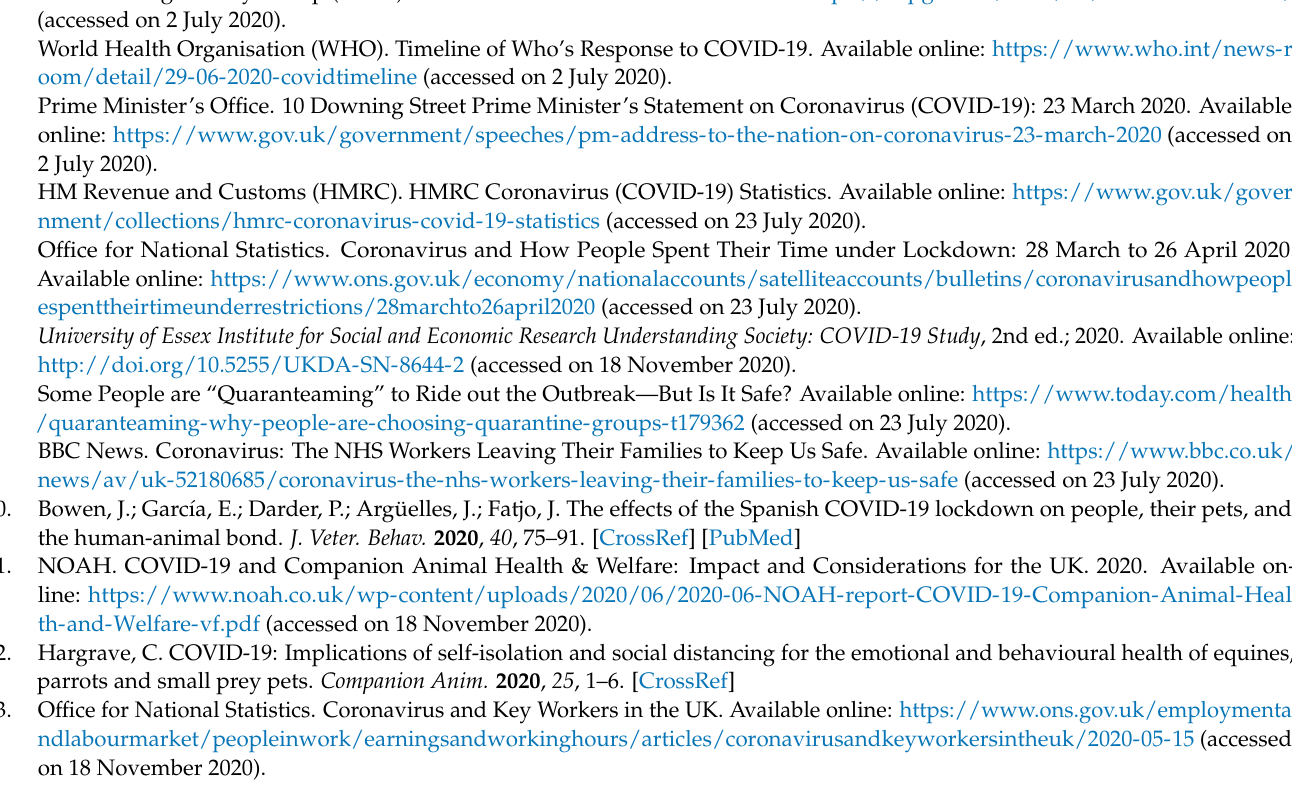
Table S2: Isolation status of questionnaire respondent and other adult household